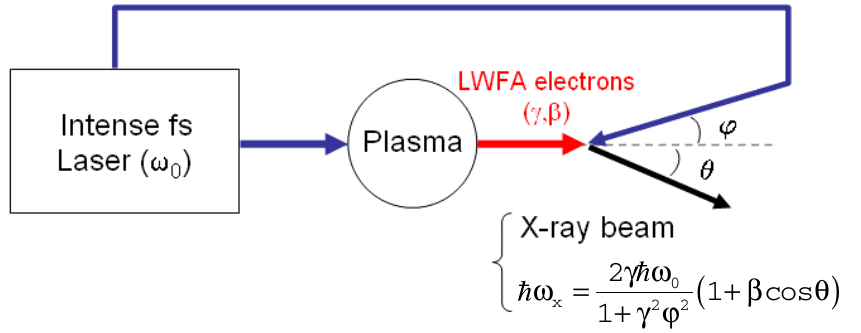
FIG. 1. (Color) Schematic of a Compton scattering x-ray experiment using LWFA electrons. The energy of the x-rays, @ ! on the angle between the laser and electron beams, ’ , as well as on the angle of observation from the electron beam direction, (cid:4) , and c 2 the electron energy, (cid:2)m 0